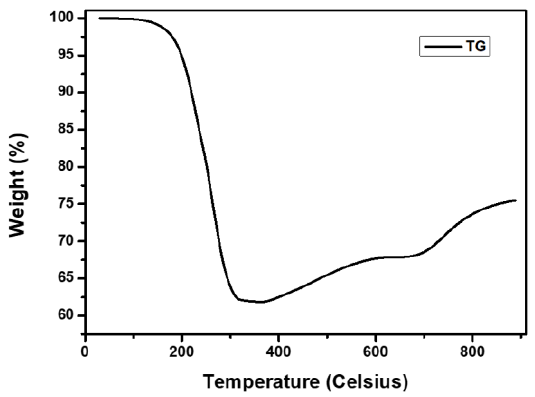
Figure 1. The outline of recovery system for iron, nickel, and chromium from stainless steel sludge.